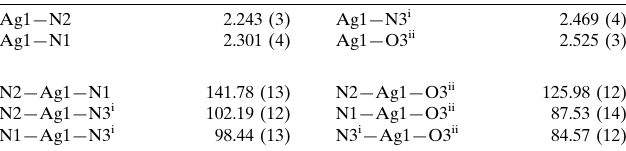
Selected geometric parameters (A˚ , (cid:4) ).